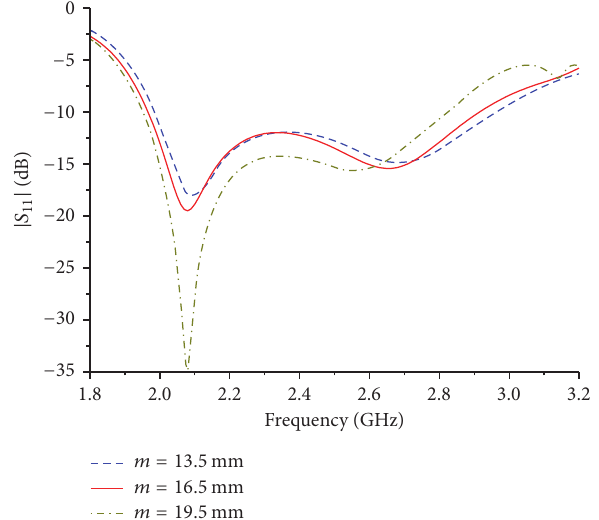
Figure 8: Simulated |𝑆 11 | of the proposed dual-polarized antenna with different 𝑚 .